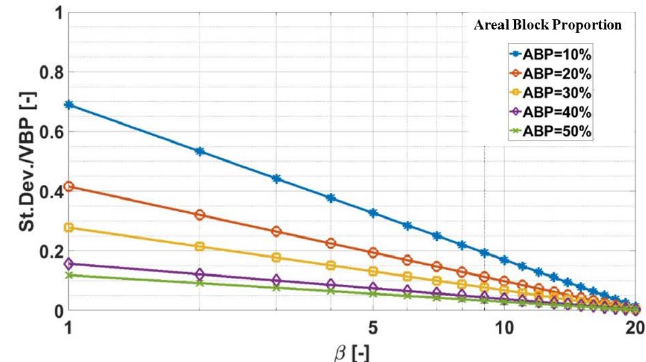
Figure 4. Uncertainty in the VBP estimate from 2D measurements, as a function of the total investi- gation surface (expressed as multiples, β, of the area of engineering interest, A c = L c2 ) and block β , of the area of engineering interest, A c = L c2 ) and block contents measured (ABP) (modified from [4]). tigation surface (expressed as multiples, contents measured (ABP) (modified from